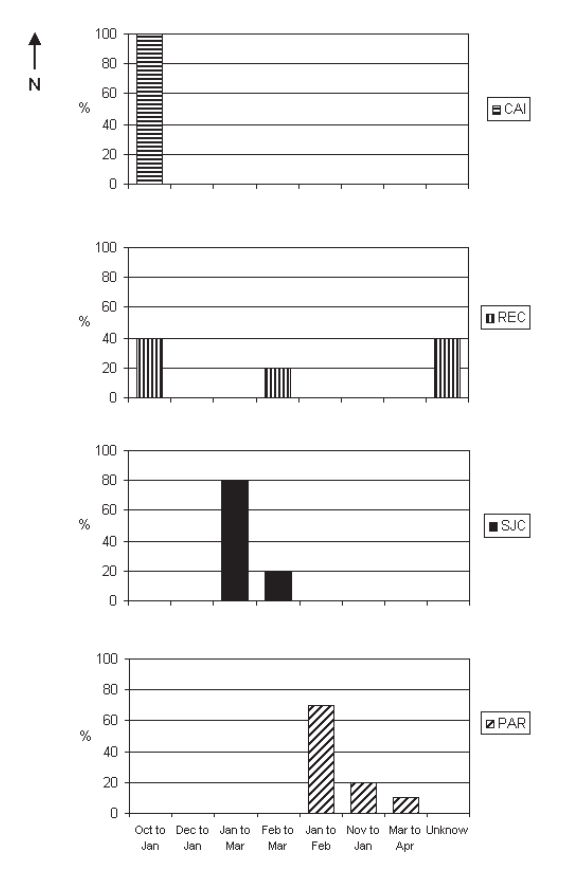
Fig. 18 . Time of the “correção” in Caiçara do Norte (CAI), Recife (REC), São José da Coroa Grande (SJC) and Paripueira (PAR) according to the interviewees (arrow indicates the north direction).